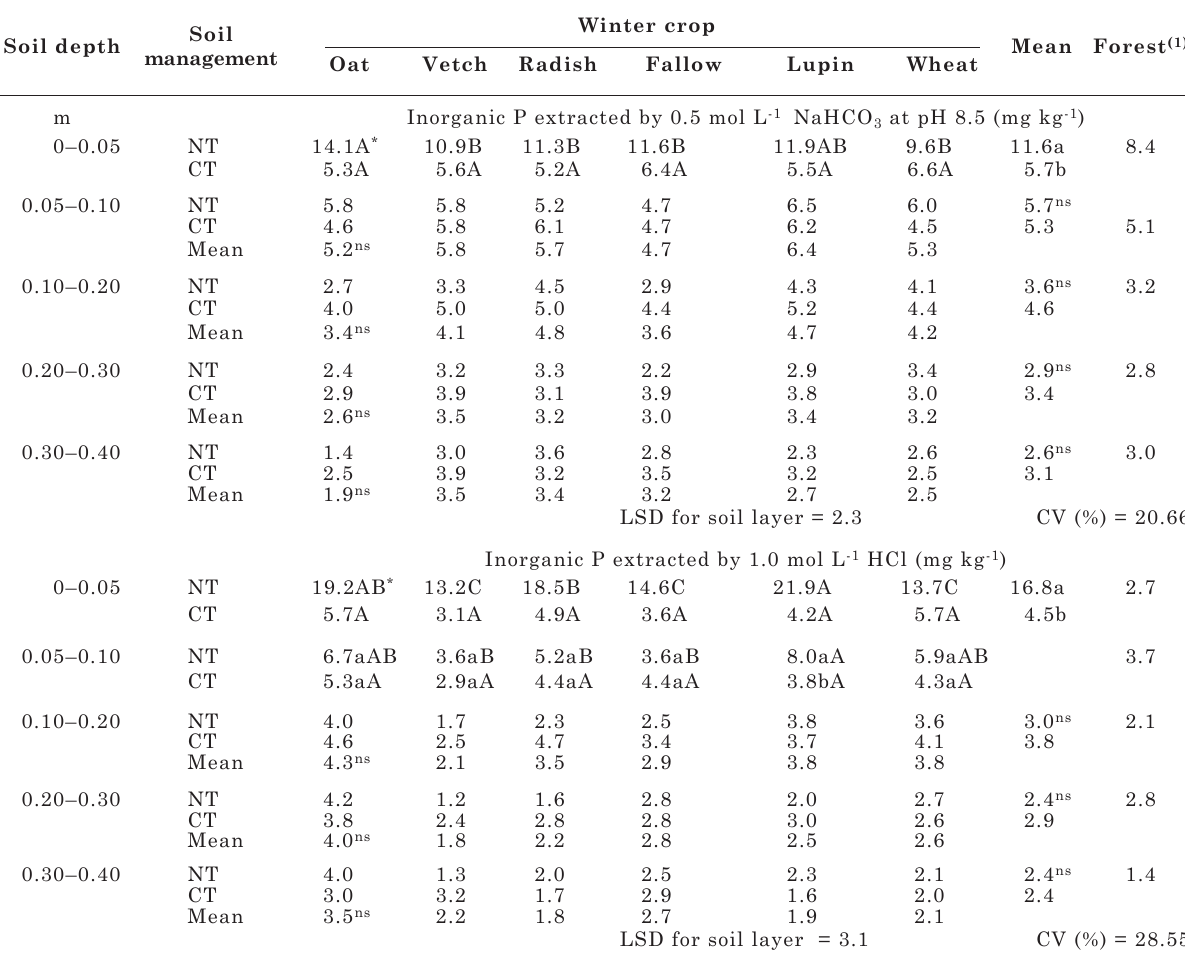
table 7. Phosphorus extracted by nahco 3 and by hcl after 23 years of different soil management and winter crops of a rhodic hapludox